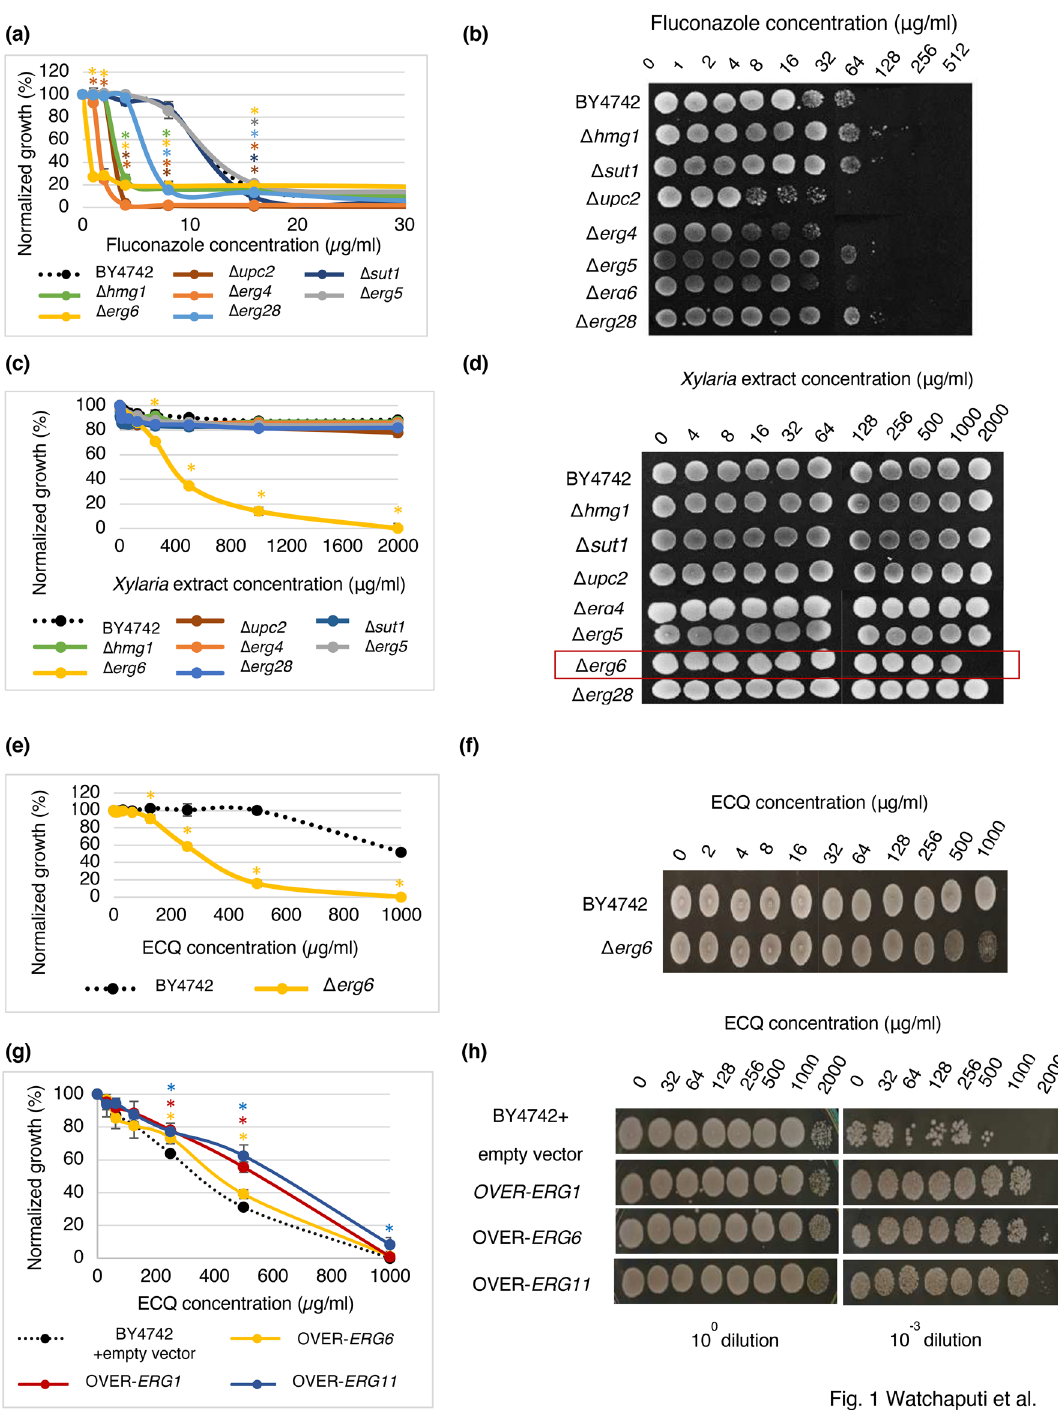
Figure 1. Susceptibility and survival of S. cerevisiae strains with a deletion or overexpression in the gene for the ergosterol biosynthesis during the treatments with different concentrations of fluconazole ( a , b ), Xylaria extract ( c , d ), or ECQ ( e – h ) using micro-dilution assays and spot tests, respectively. Cells from micro-dilution assays were directly spotted (10 0 dilution) or diluted 1000 times (10 –3 dilution) prior to be spotted on YPD plates. Growth of the overexpression strains were compared with the wild-type strain. * was referred to the mean difference with significant p value of <